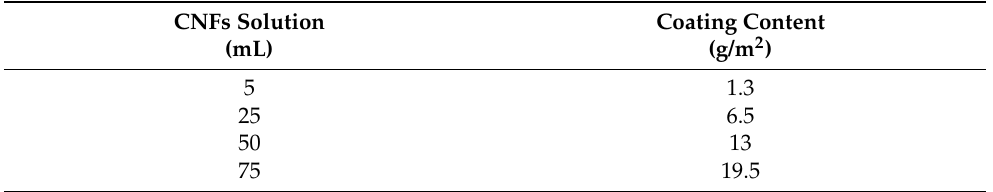
Table 1. Volumes of the cellulose nanofiber solutions used in the filtration experiments and the respective amounts of CNFs on membrane